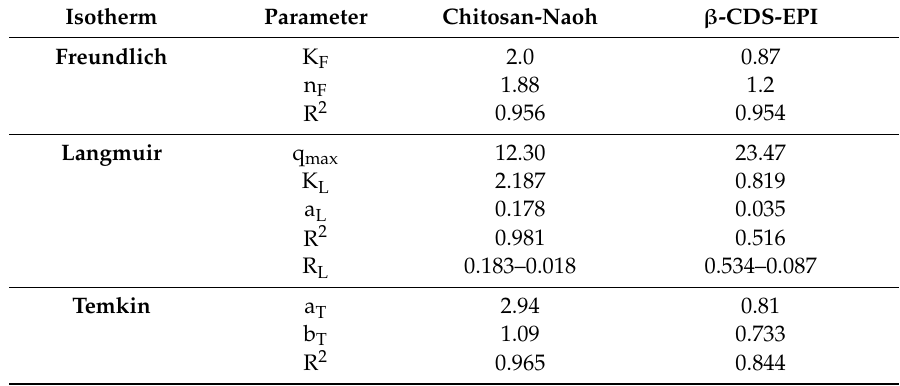
Table 3. The adsorption isotherm constants obtained for the chitosan-NaOH and β -CDs-EPI polymers.